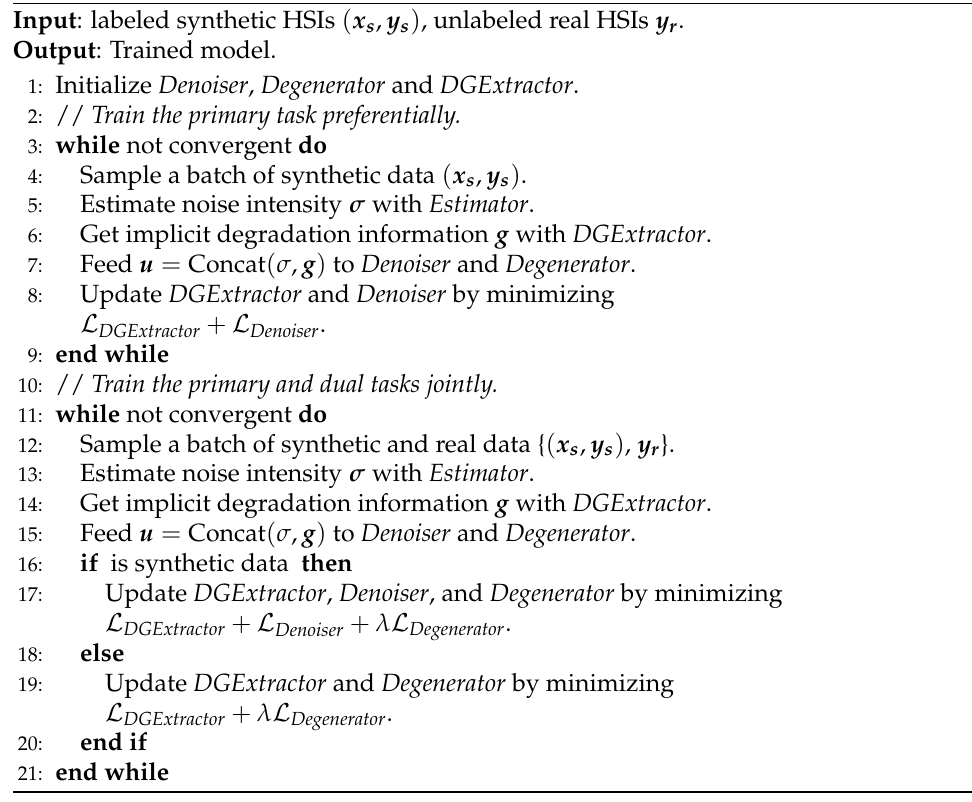
Algorithm 1 The priority dual learning algorithm.